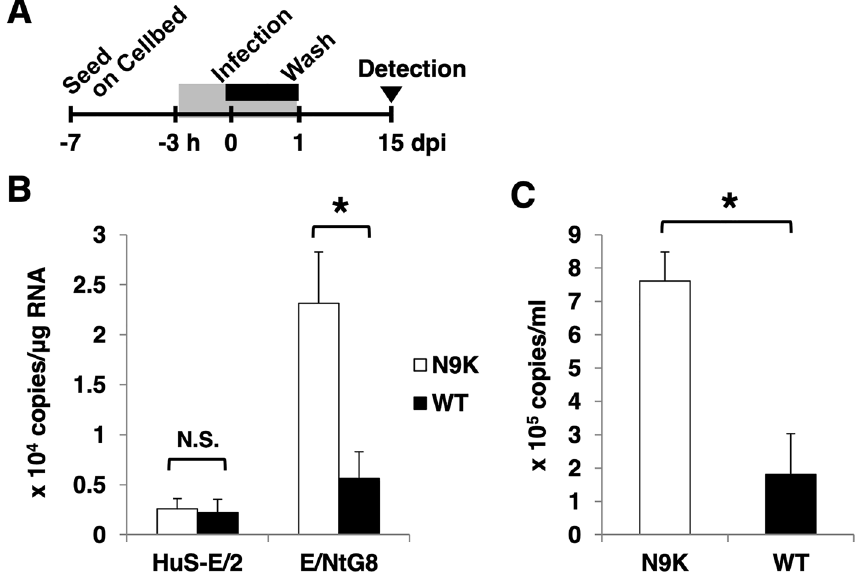
Figure 2. ( A ) Schema of the schedule for HBVcc infection experiment using HuS-E/2 cells and E/NtG8 cells cultured on Cellbed is shown. Inoculation time of the 3D-cultured cells with HBVcc is shown in the black box. The time of treatment with HBV preS1 peptide is shown in the gray box. After infection, the cells were cultured for 2 weeks. ( B ) The amount of HBV pgRNA in 3D-cultured HuS-E/2 cells and E/NtG8 cells infected with HBVcc were evaluated by qRT-PCR at 15 dpi. Data of the cells treated with myr-47WT (WT) or myr-47N9K (N9K) during the inoculation are shown as the following panels. ( C ) The culture media of the HBVcc-infected 3D-cultured E/NtG8 cells were collected every 2 days. The amounts of extracellular HBV DNA in the media were evaluated by qPCR at 15 dpi. Levels of significance: * and N. S. indicate “p < 0.05” and “no significant difference”,